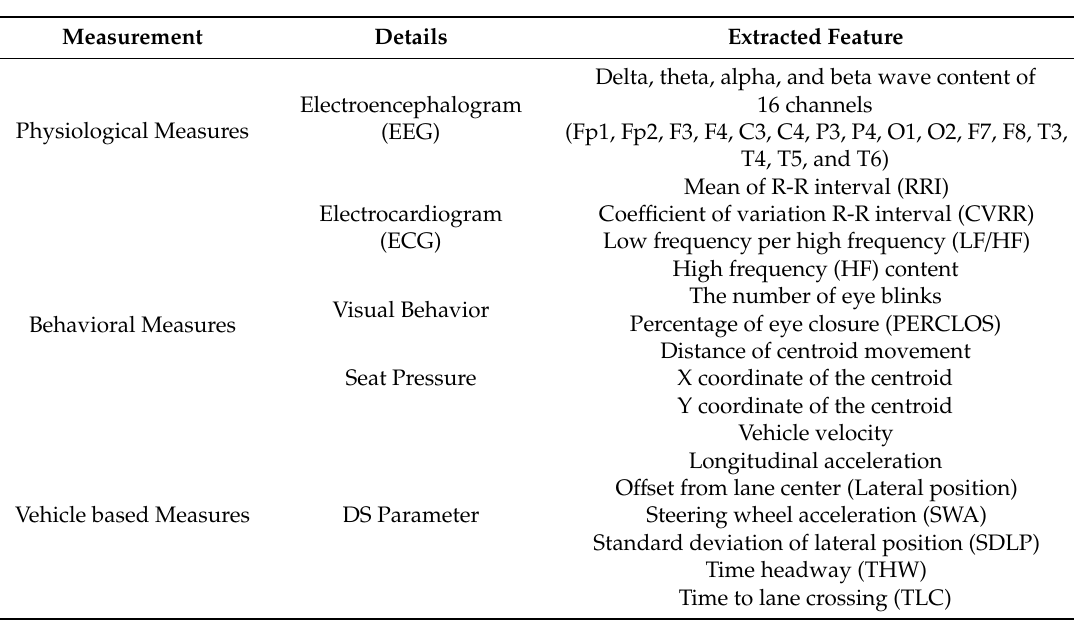
Figure 3. Procedure of data processing [20]. Table 2. Details of extracted features.